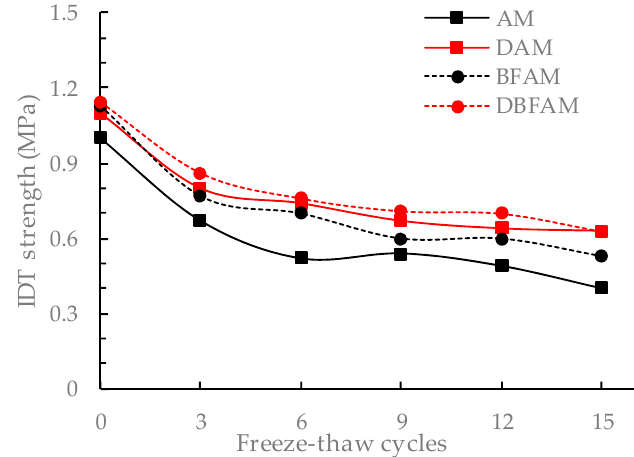
Figure 17. IDT strength under F–T cycles.